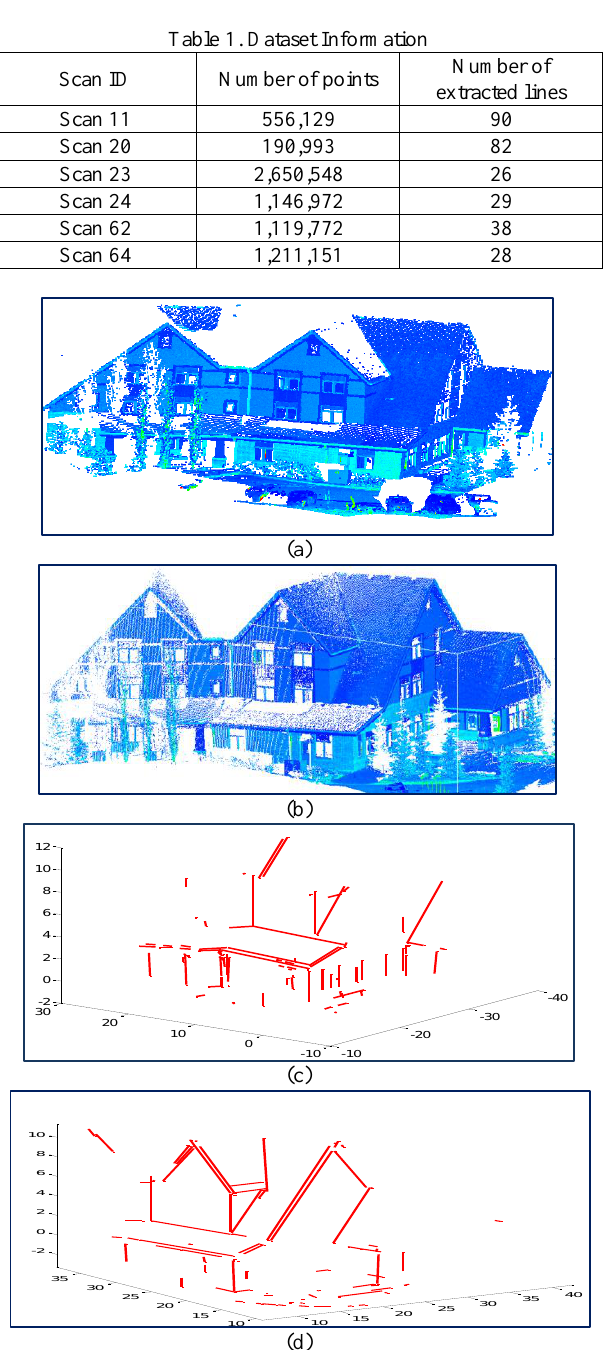
Figure 9. Scan 11 displayed according to the intensity values (a), scan 20 displayed according to the intensity values (b), extracted linear features from scan 11 (c), and extracted linear features from scan 20 (d)